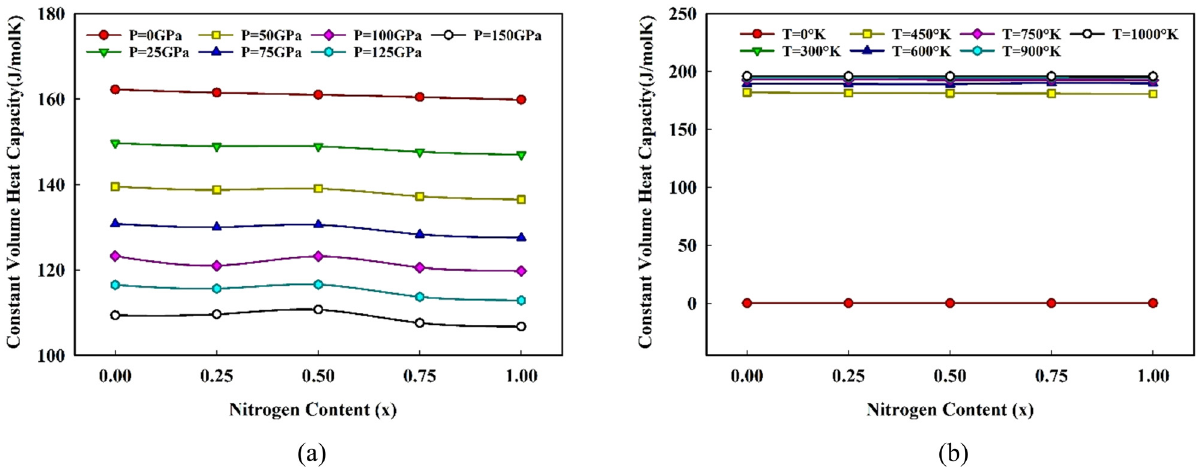
Figure 7: Constant volume speci fi c heat of ZrC ( 1 − x ) N x as a function of nitrogen content ( x ) for ( a ) di ff erent pressures at 300 K and ( b ) di ff erent temperatures at zero